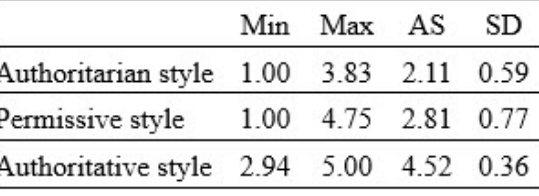
Table 1. Basic parameters of parenting